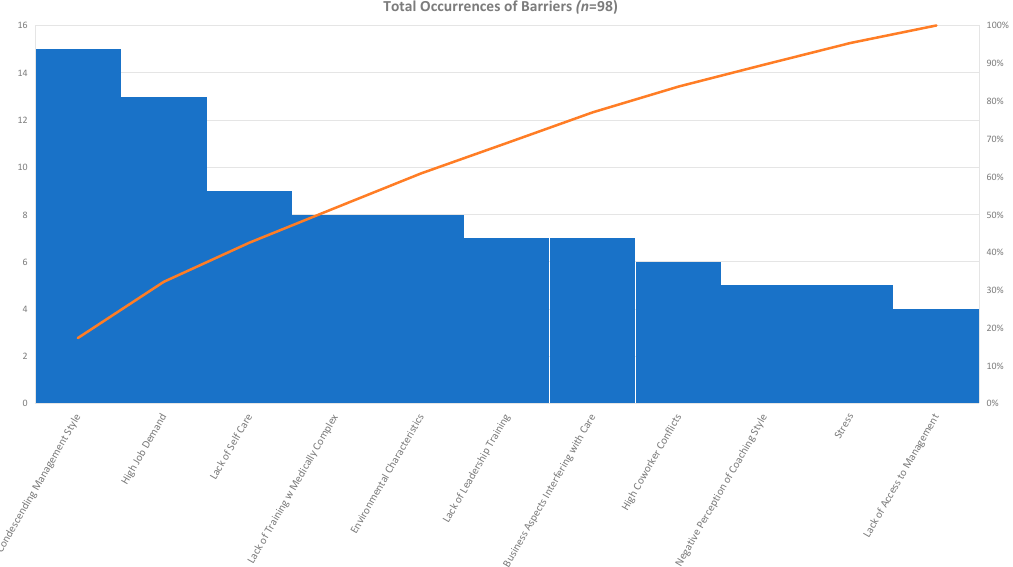
Figure 3. Total occurrences of top barriers in the review with the first six barriers comprising 60.82% of the occurrences.